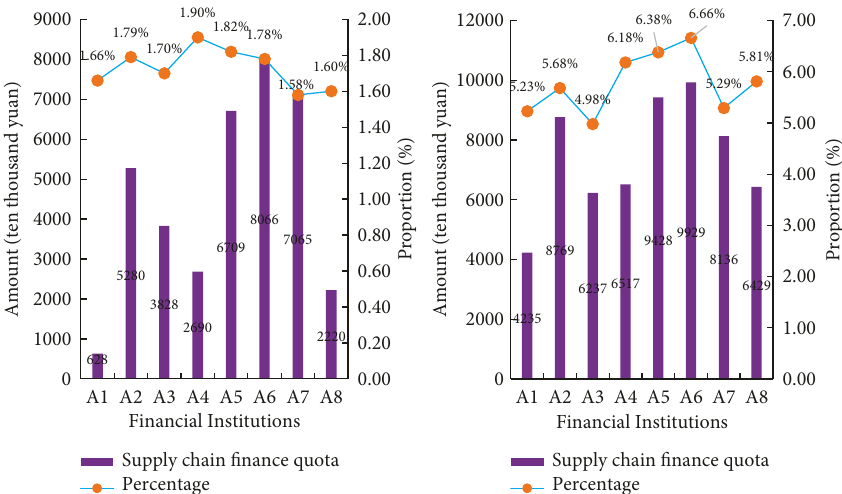
Figure 7: Supply chain of financial institutions and their proportions before and after management.